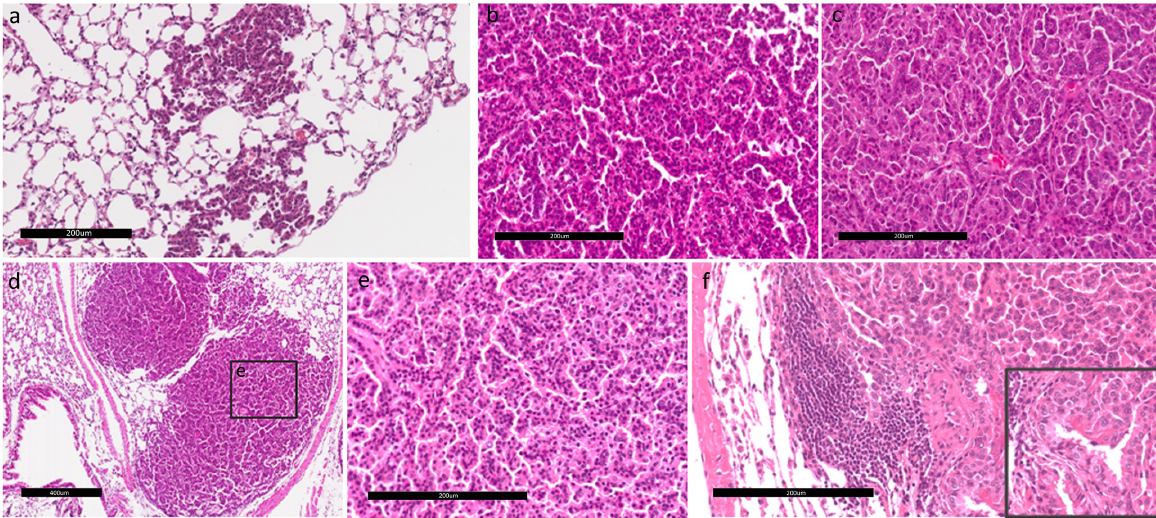
Fig 1. Tumor progression and histopathological phenotype in a transgenic mouse model. Hematoxylin and eosin (H&E)-stained tumors from Tg mice at various stages of age: (a) an atypical adenomatous hyperplasia (AAH) lesion progressing to adenocarcinoma in situ (AIS). The scale bar showed200 μ m in distance. (b) Uniform nuclei are shown in an AIS. The scale bar showed200 μ m in distance. (c) Pleomorphicnuclei are shown in an adenocarcinoma. The scale bar showed200 μ m in distance. (d) Formation of lung adenocarcinomas. The scale bar showed400 μ m in distance.(e) Adenocarcinoma with glandular/acinar architecture and desmoplasia. The scale bar showed200 μ m in distance. (f) Invasive adenocarcinoma displayingmixed cellularphenotypes. Cells of the invasive componentwere more columnarand of highernuclear grade (inset). The scale bar showed200 μ m in distance. Panels a and d were at 100x magnification; panels b, c, e, and the inset were at 400x magnification; panel f was at 200x magnification.